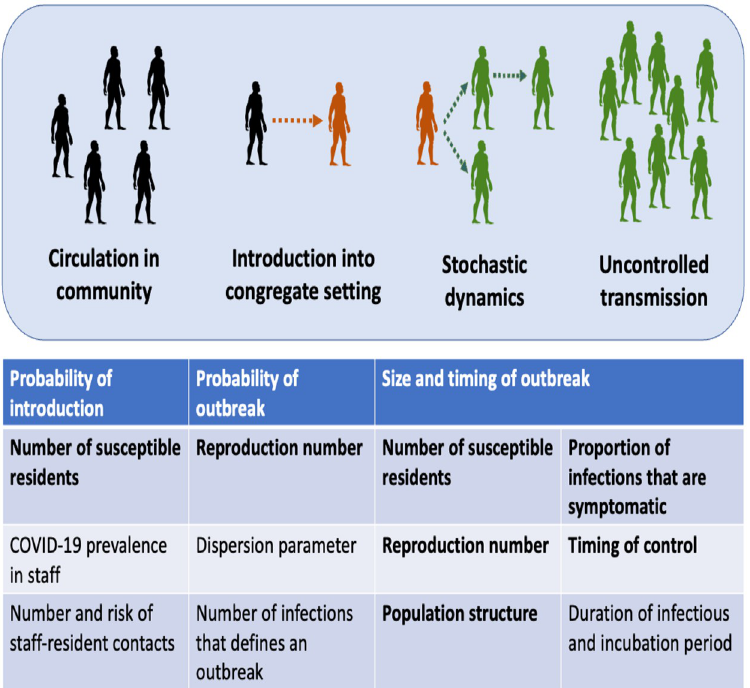
Fig 1. Stages of an outbreak. For an outbreak to occur in a congregate setting, an infection that circulates in the community must be introduced into the congregate setting. Then stochastic dynamics determine whether or not an introduction initiates a large outbreak. Once an outbreak occurs, uncontrolled transmission dictates the size and time course of the outbreak. The table lists the variables that are used in each step of the model. The bolded variables are the variable that are impacted by control interventions that are described in the